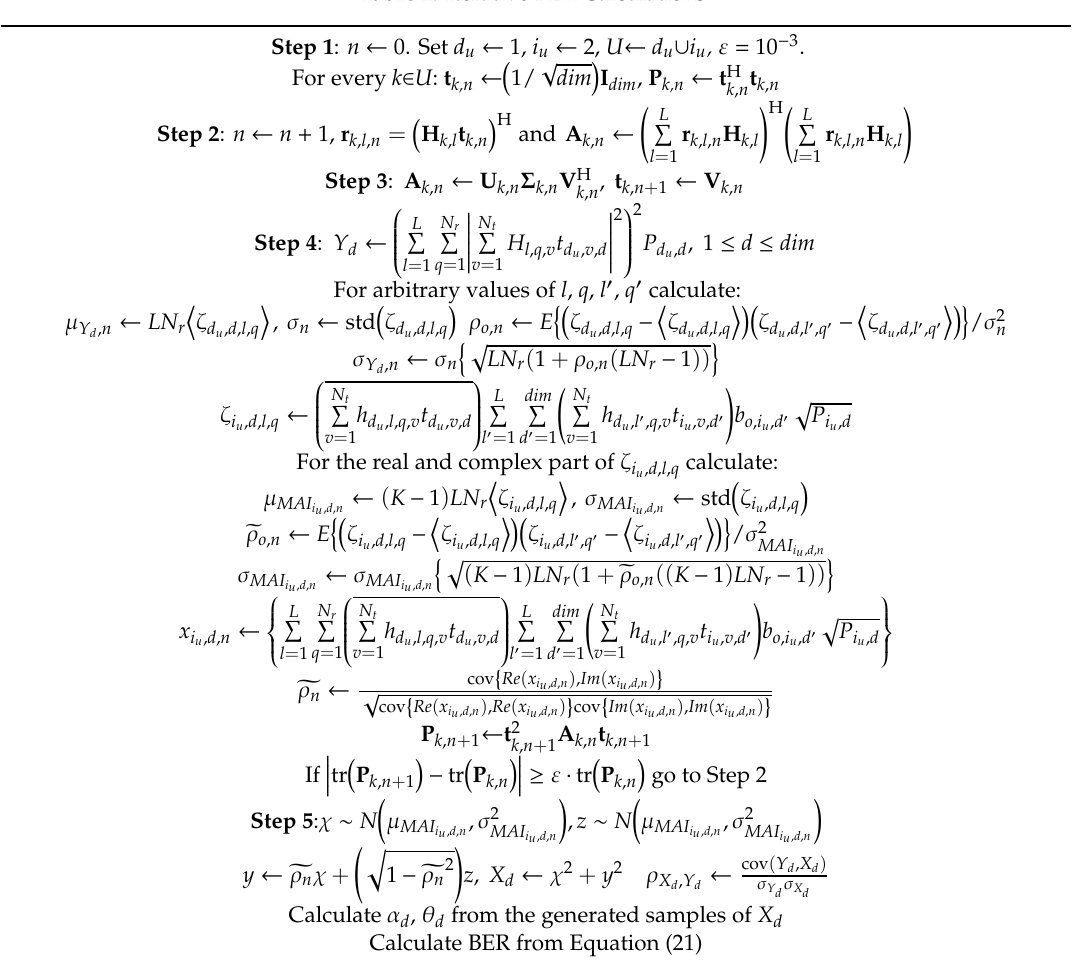
Table 1. Iterative BER